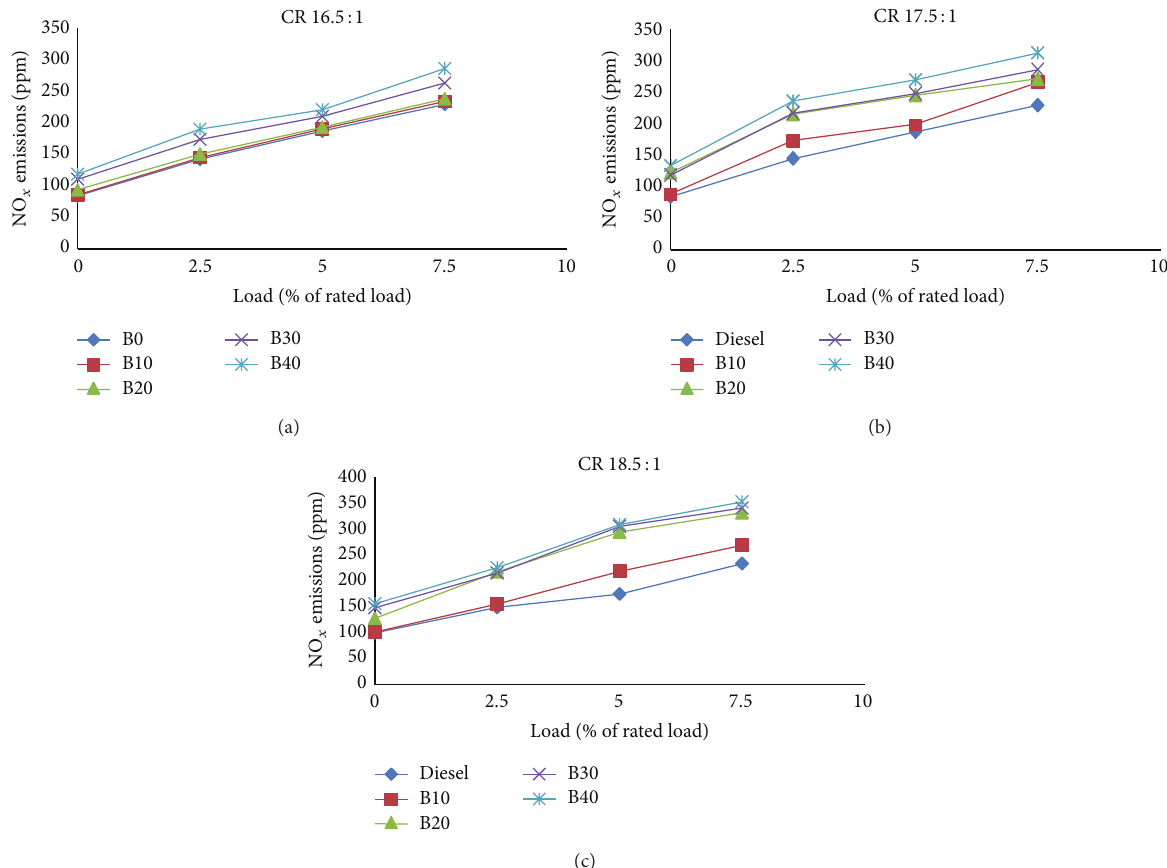
(2) Effect of Compression Ratio . On an average, the CO emission reduced by 14.28% when compression ratio was increased from 16.5 : 1 to 18.5 : 1 for the blend B40 at 75% of rated load conditions and as it can be seen from Figure